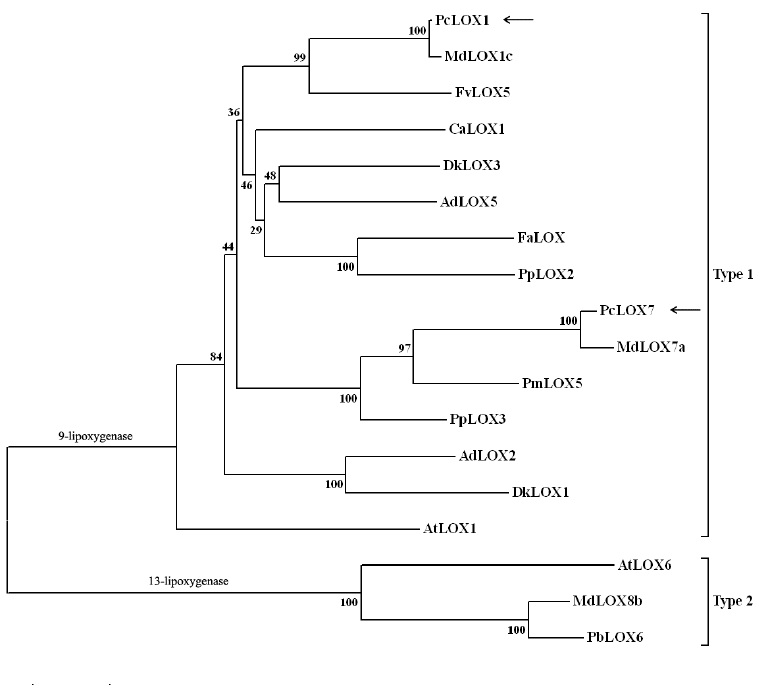
Fig. 2: Phylogenetic relationship of PcLOXs to other LOX proteins. The accession numbers of plant LOX proteins in GDR or GenBank are: PcLOX1 ( Pyrus communis , PCP003542), PcLOX7 ( Pyrus communis , PCP003539), MdLOX1c ( Malus × domestica , AGK82778), MdLOX7a (AGI16416), MdLOX8b (AGK82795), PpLOX2 (ACH90245), PpLOX3 ( Prunus persica , ACH91370), AdLOX2 ( Actinidia deliciosa , ABF60002), AdLOX5 (ABF60001), FaLOX ( Fragaria × ananassa , CAE17327), DkLOX1 ( Diospyros kaki , AEZ50136), DkLOX3 (AEZ50135), CaLOX1 ( Capsicum annuum , ACO57136), PmLOX5 ( Prunus mume , XP_008245950), FvLOX5 ( Fragaria vesca , XP_004302420), AtLOX1 ( Arabidopsis thaliana , NP_175900), AtLOX6 (CAG38328), and PbLOX6 ( Pyrus × bretschneideri ,